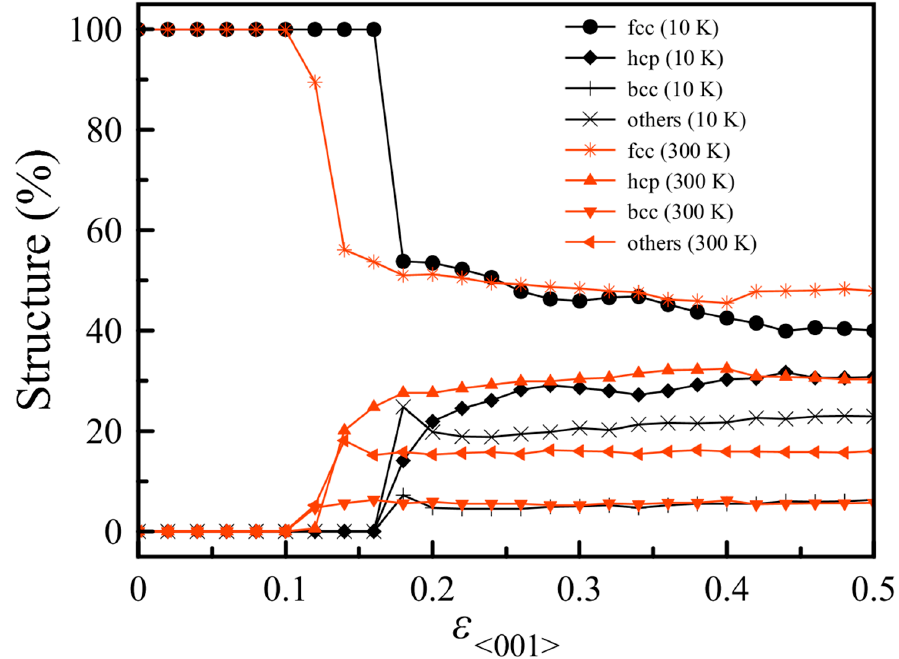
Figure 4. Structural evolution for uniaxial tensile loading of TiAl alloy in the <001> direction. The black and red circles represent the loading process at 10 and 300 K, respectively.